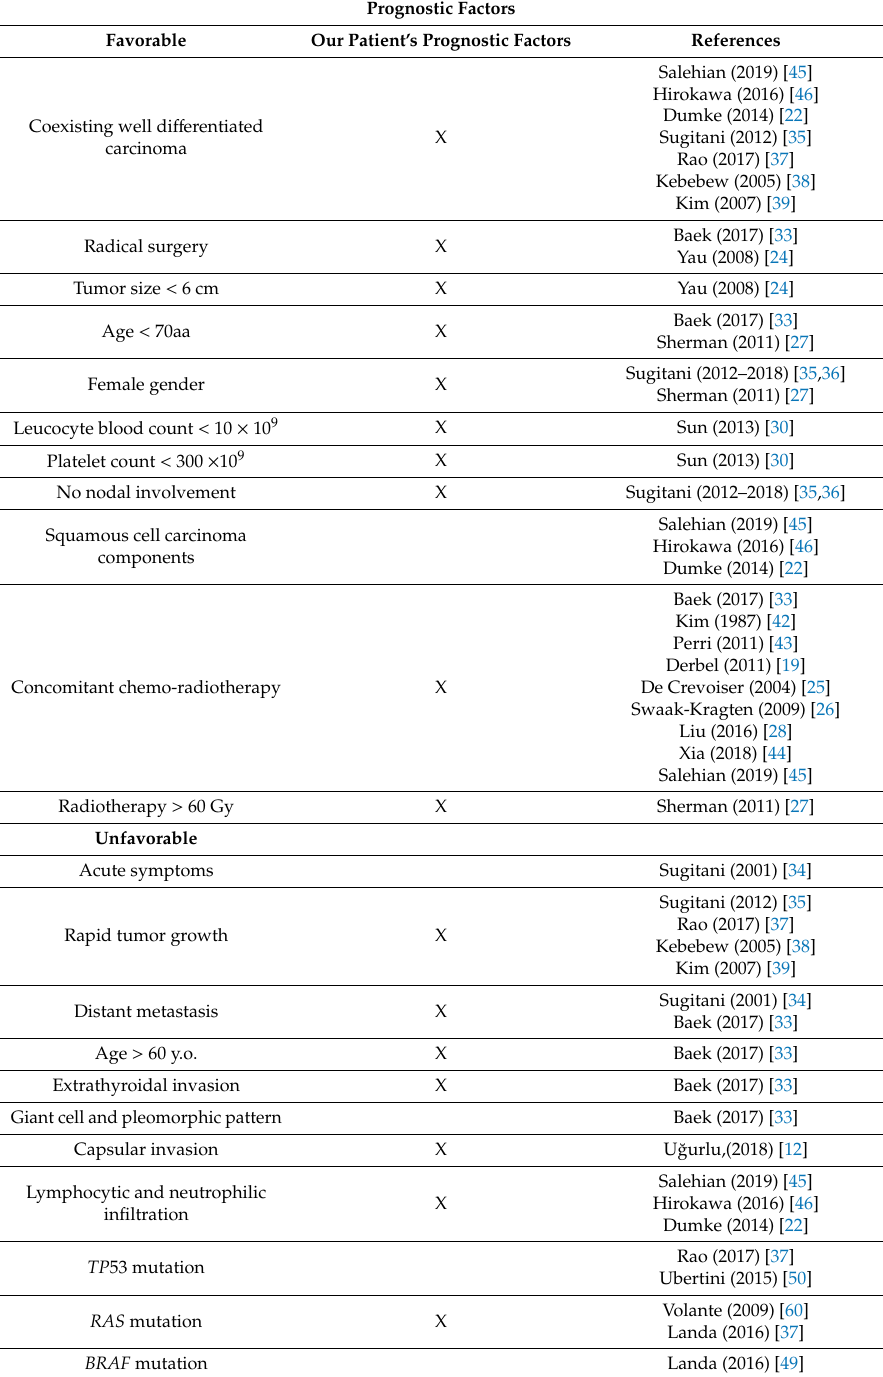
Table 3. Prognostic factors from the literature data and in our